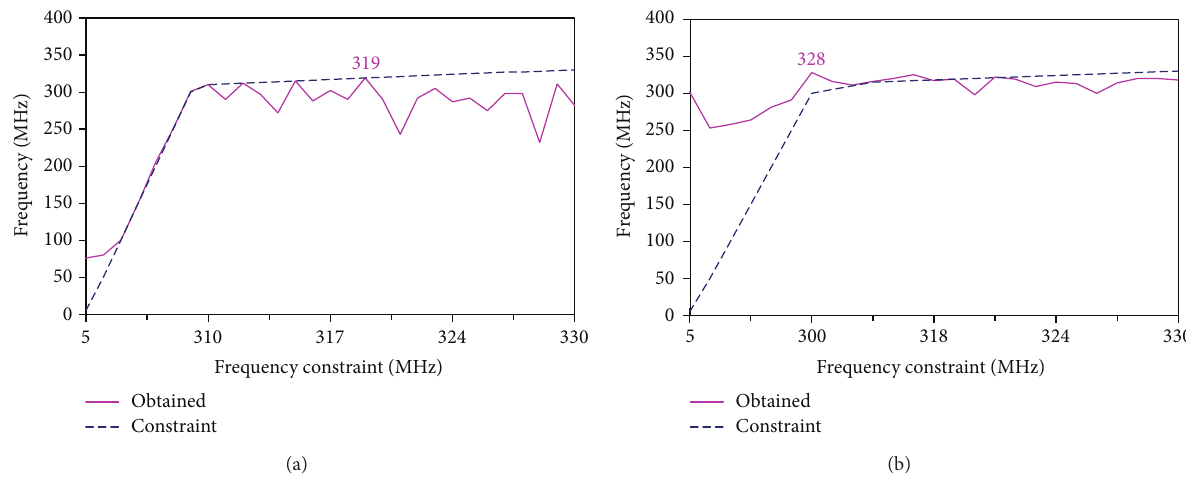
Figure 13: Frequency-constraint search of 8-tap FIR filter for (a) Virtex-4 LX100 and (b) Stratix-II S180, using ISE 12.1 and Quartus II 10.1 (zoomed in range of [300 MHz, 330 MHz]).